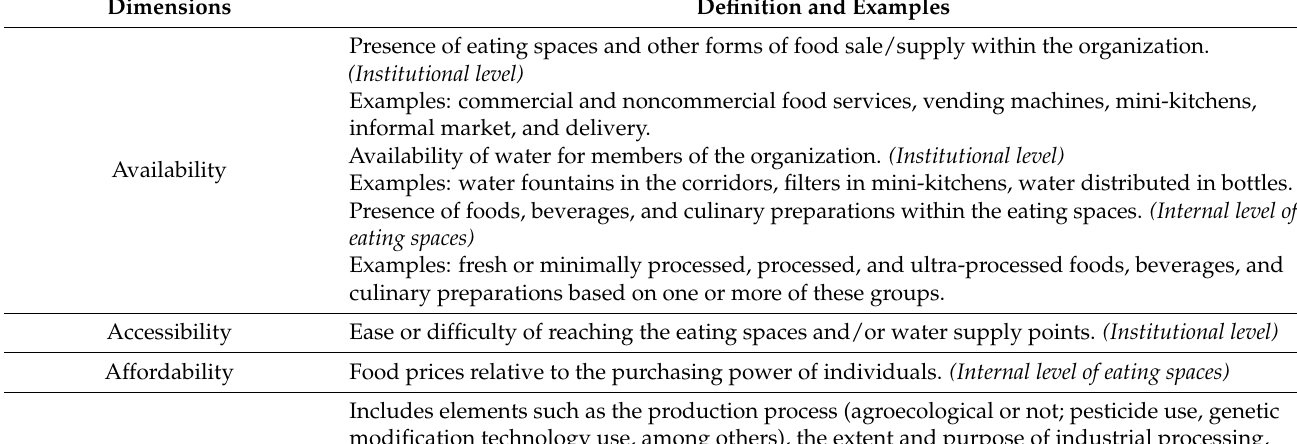
Table 1. Definitions and examples of the dimensions of the food environment at the institutional level and internal level of food